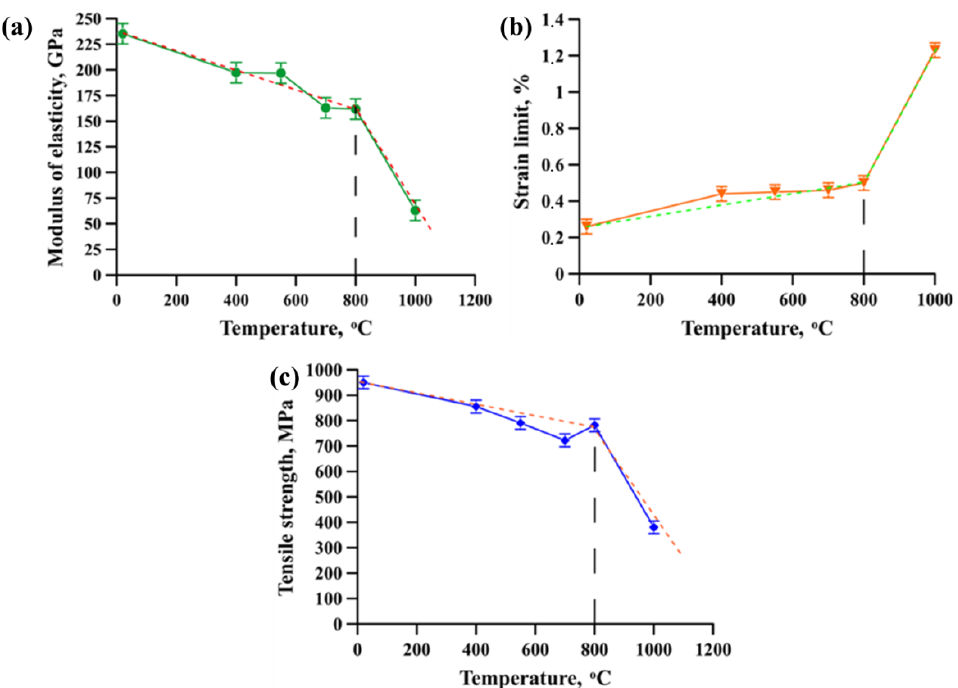
Figure 6. Curves of the modulus of elasticity ( a ), deformation limit ( b ) and ultimate strength ( c ) versus the temperature in the course of bending tests. Table 3. Measurement results of elastic modulus, strain limit and strength limit as a function of temperature during bending tests.